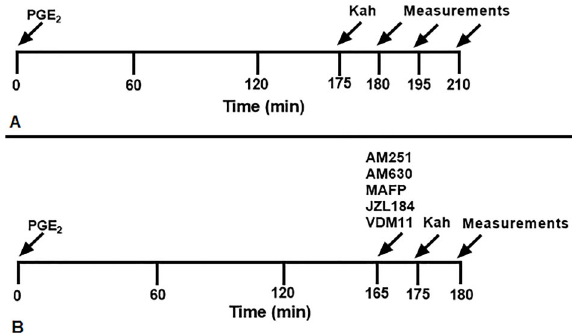
Figure 1. Schematic diagram of the experimental protocol. A , Kahweol (Kah) was administered 175 min after the local administration of prostaglandin E 2 (PGE 2 ) (2 m g) and the antinociceptive response was measured prior to and 180 min, 195 min, and 210 min after PGE 2 injection. B , Kah was administered in the right hind paw 175 min after local injection of PGE 2 . The cannabinoid drugs AM251, AM630, MAFP, JZL184, or VDM11 were given 10 min prior (165 min) to Kah intraplantar administration and measurements were performed prior to and 180 min after PGE 2 administration.